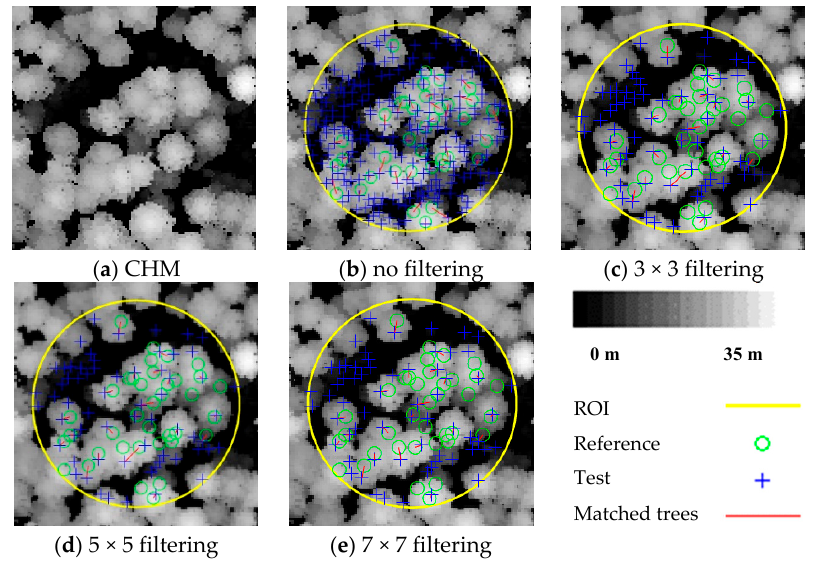
Figure 8. Matching results of no filter, 3 × 3, 5 × 5, and 7 × 7 Gaussian filters. Table 2. Matching Scores of all Plots and their RMS_M for different Gaussian filters. Table 6. Matching results of single-tree detection methods. Our single-tree detection method with 4- N GOC achieves a maximum RMS_M over the dataset.